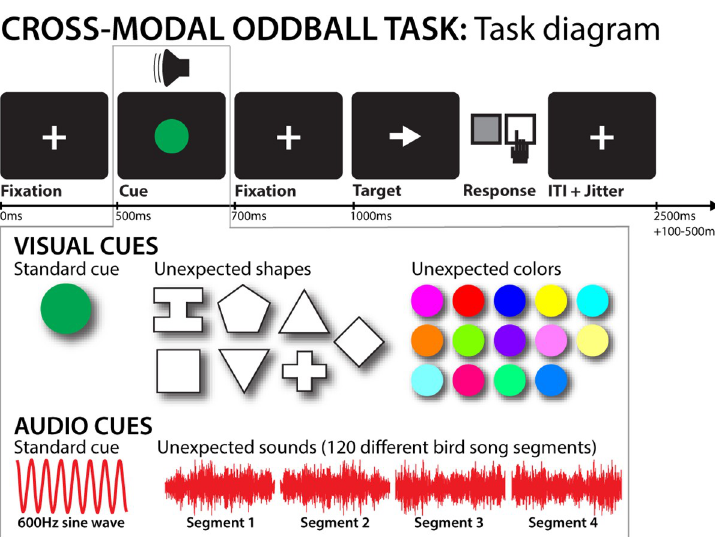
Fig 1. Cross-modal oddball task diagram. The top row depicts the trial timing. The gray box attached to the cue illustrates the different cue properties by trial type. Each cue consisted of a visual and an auditory component. Standard visual cues consisted of a green circle, whereas unexpected visual cues were one of seven non-circular shapes shown in one of fourteen non-green colors. Standard auditory cues consisted of a 600Hz sine wave, whereas unexpected auditory cues were one of 120 individual unique birdsong segments. On a trial that contained an unexpected cue in one domain, the other dimension of the cue always contained the standard component (i.e., a cue was either unexpected in the visual or the auditory domain, never in